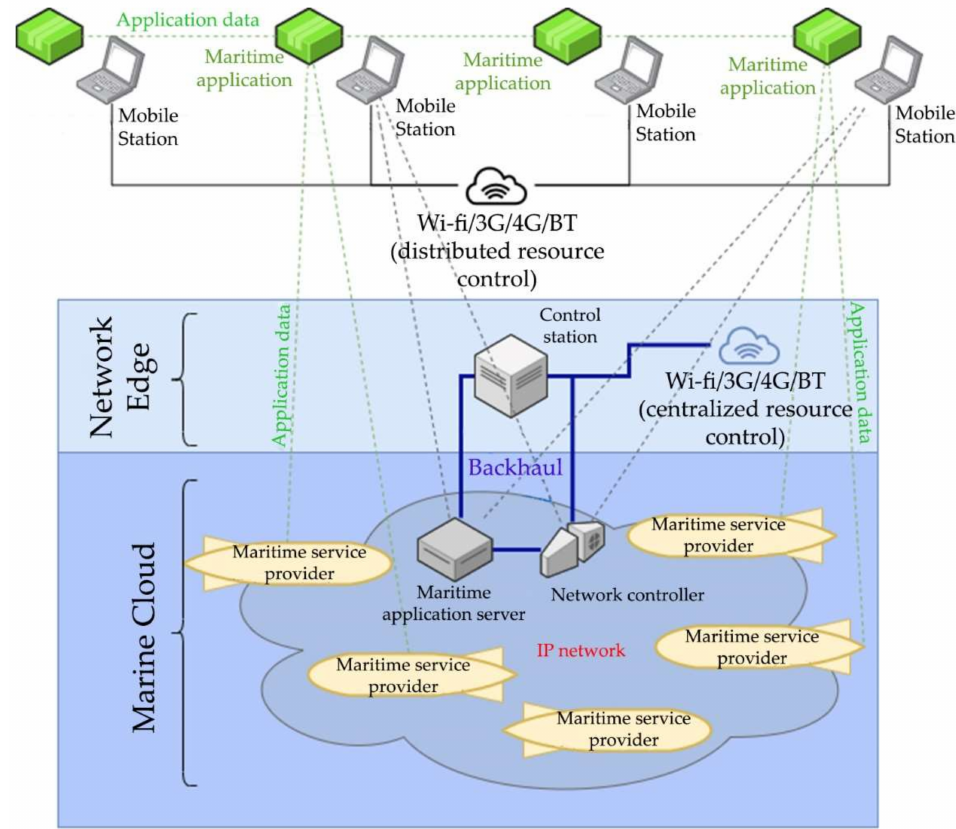
Figure 7. Machine-type communication marine network